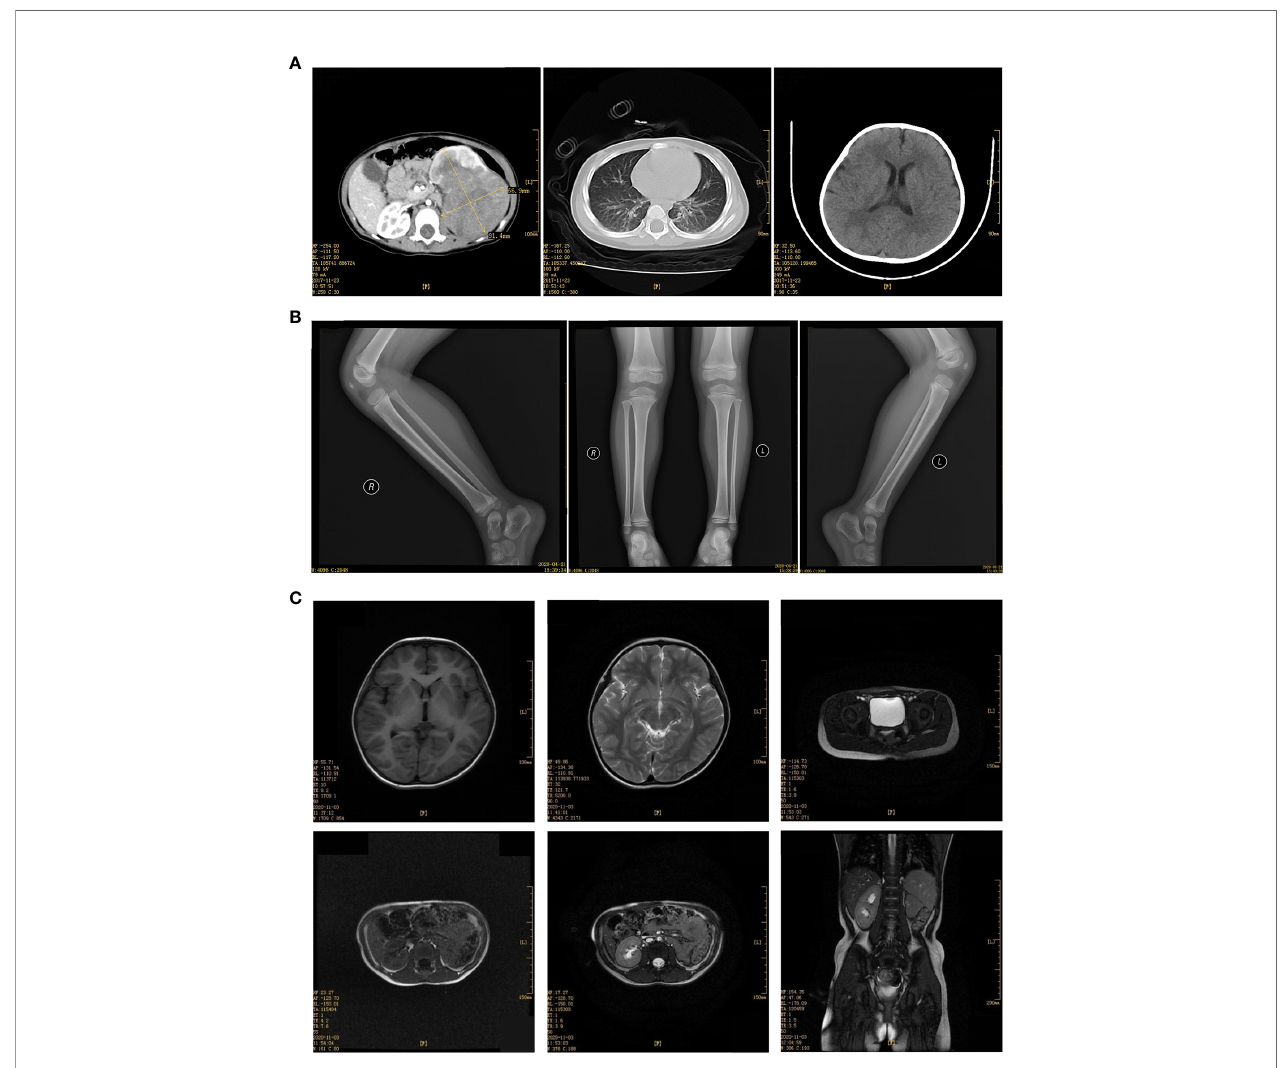
FIGURE 3 | (A) Enhancement of CT plain scan of chest and abdomen before the operation (December 29, 2017). (B) Bilateral hip joint X tablets after the operation (April 21,2020). (C) MRI scan of the head, chest, abdomen, and pelvis after the operation (December 07,